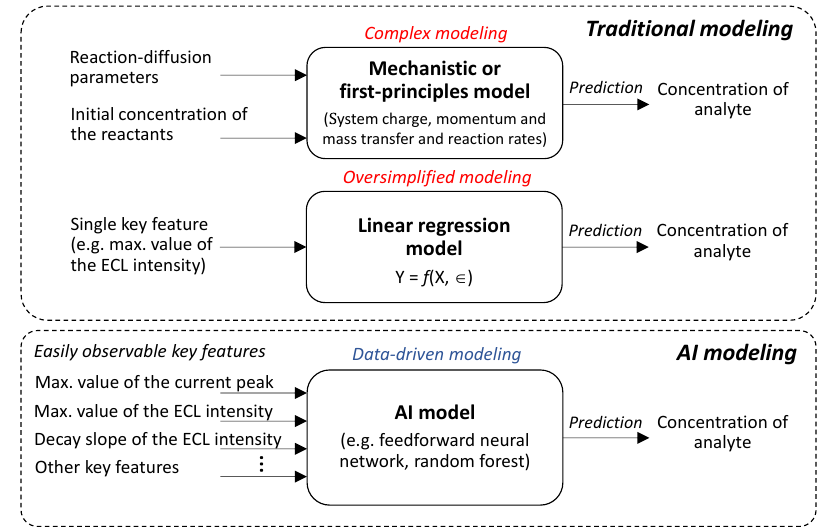
Figure 1. Schematic diagram of the comparison of the traditional and artificial intelligence (AI) modeling in the estimation of the analyte concentration.